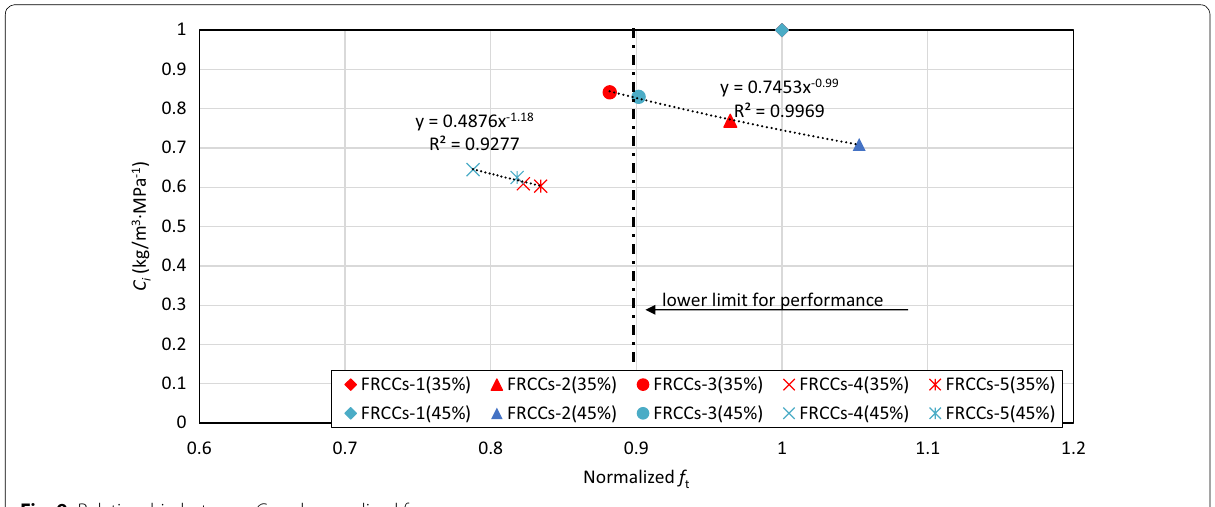
Fig. 9 Relationship between C i and normalized f t